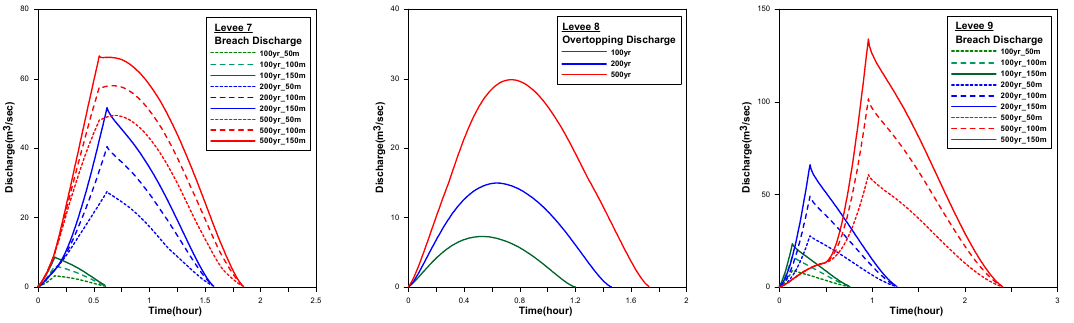
Figure 9. Levee failure and overtopping hydrographs for different scenarios.